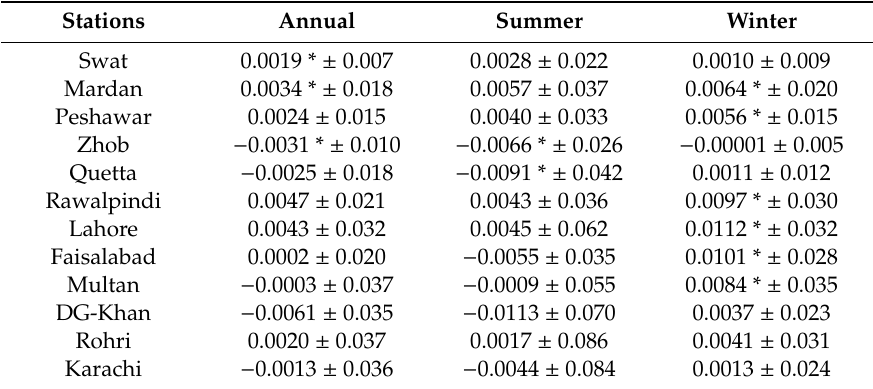
Table 2. Magnitude of seasonal and annual AOD trends (per year) for selected regions during (2003–2017); based on AOD data acquired from MODIS-Terra DB product, * represents statistically significant trends over the selected